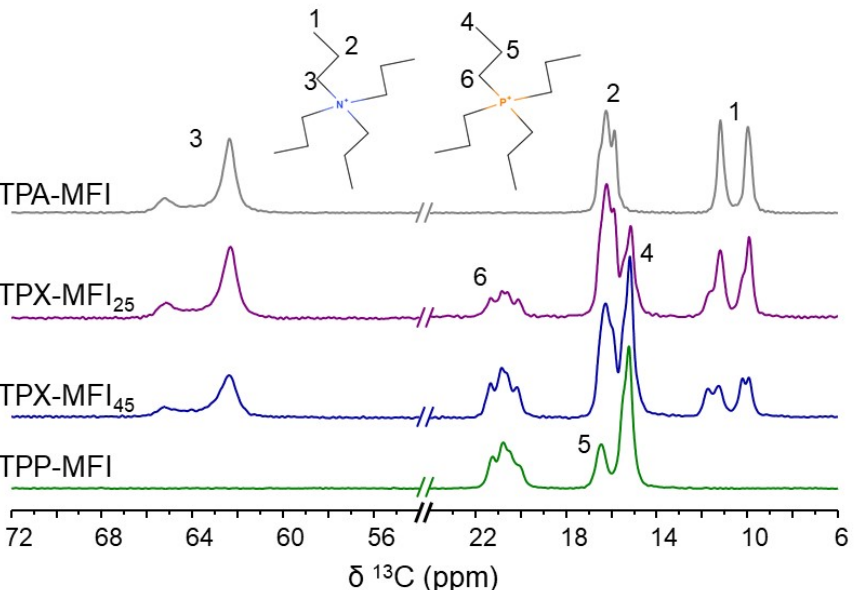
Figure 5. 1 H/ 13 C CP MAS NMR spectra of silicalite-1 samples synthesized using TPA, TPP, and mixtures of them as OSDAs.